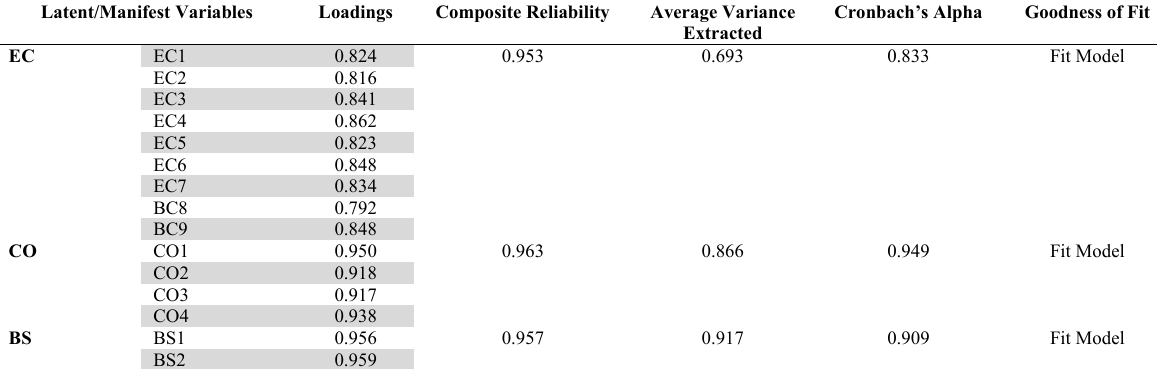
Measurement Model of Variables Latent/Manifest Variables Loadings Composite Reliability Average Variance